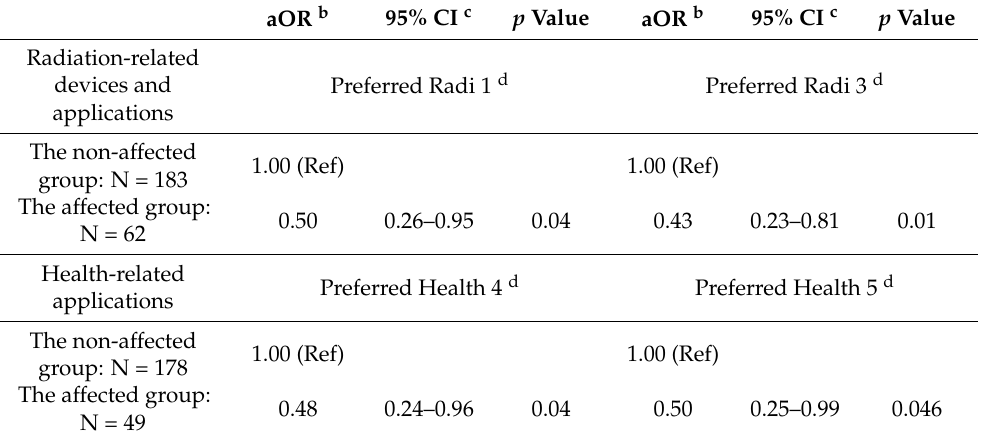
Table 5. Factors associated with attitude in the functioning of radiation- and the health-related applications using logistic regression analysis a . aOR b 95% CI c p Value aOR b 95% CI c p